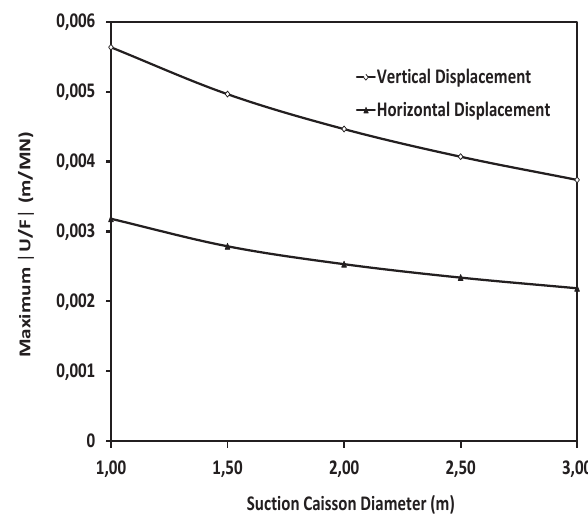
Figure 8: Horizontal displacement amplitude │ U/F │. ̶ Figure 8 Horizontal displacement amplitude │U/F│̶ Vertical and horizontal dynamic response of suction caisson foundations